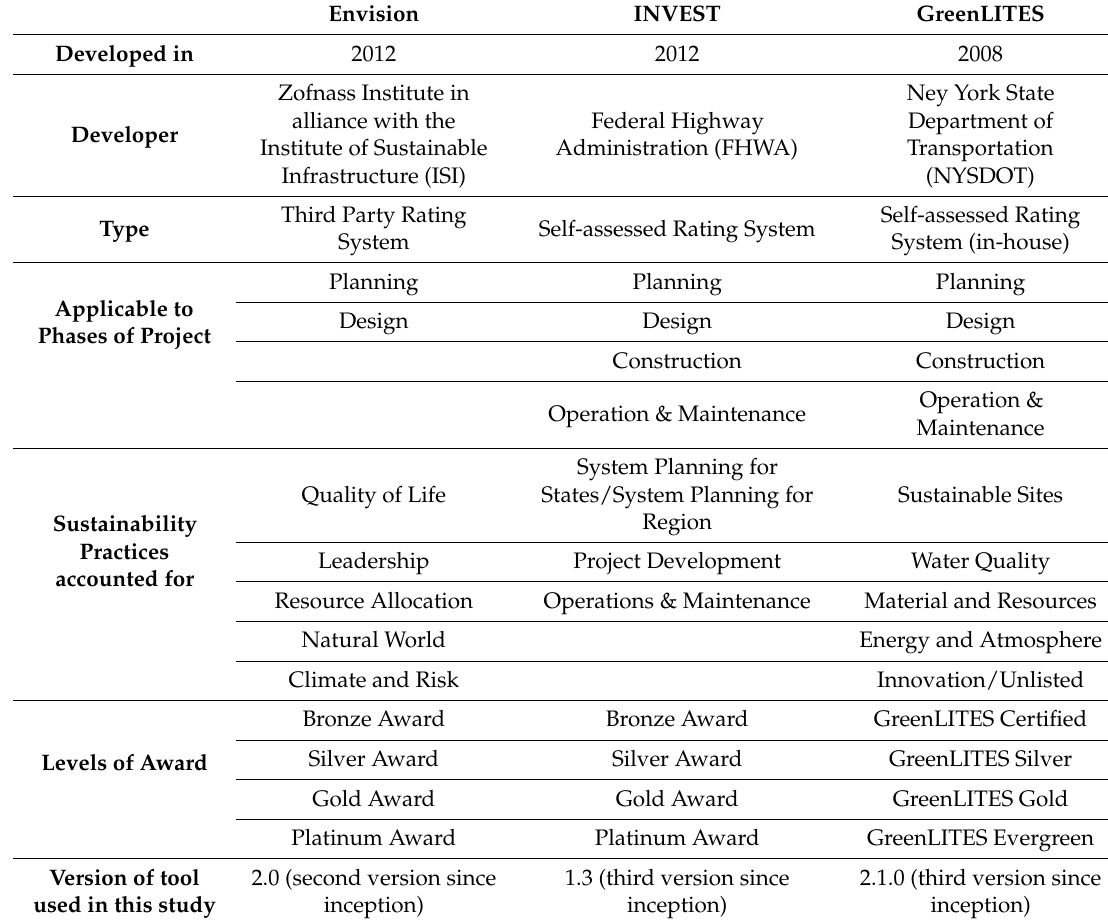
Table 1. Summary of the rating